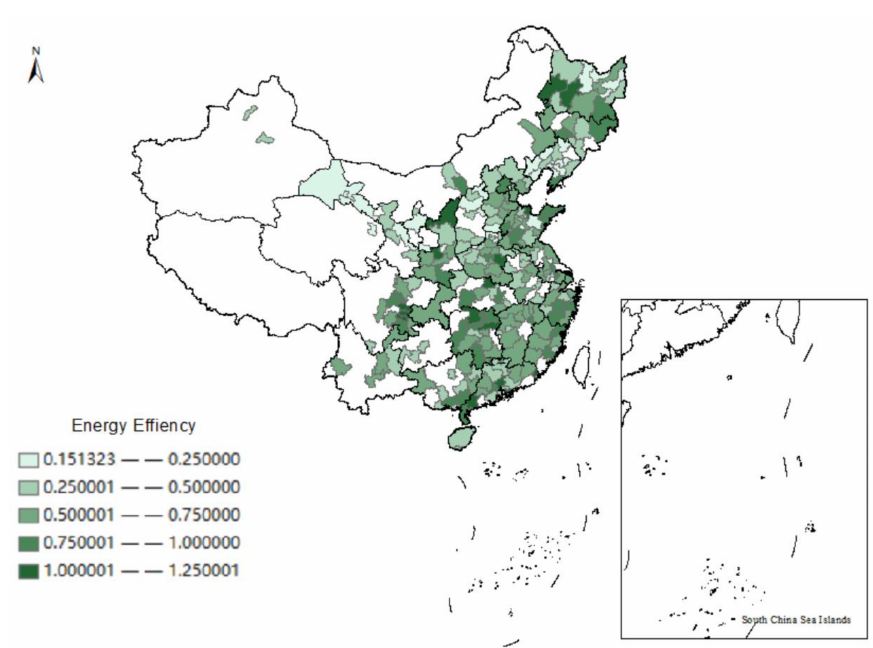
Figure 2. Spatial distribution of energy efficiency in China in